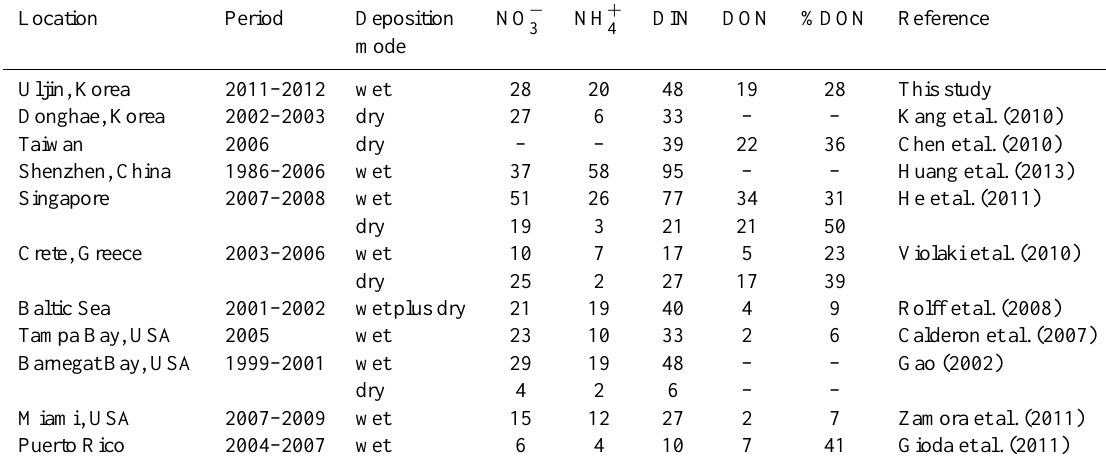
Table 4. Annual atmospheric deposition fluxes of reactive nitrogen (mmolNm − 2 yr − 1 ) at coastal and marine locations estimated based on long-term measurements during the last